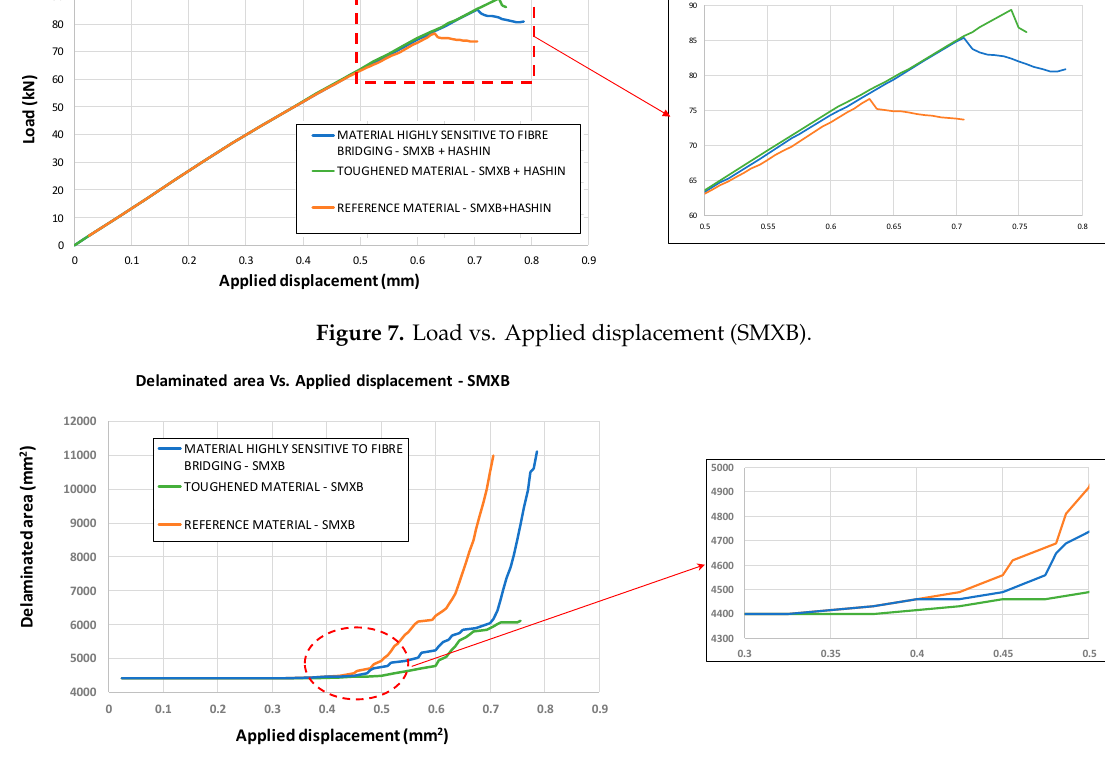
Figure 8. Delaminated area vs. Applied displacement (SMXB).